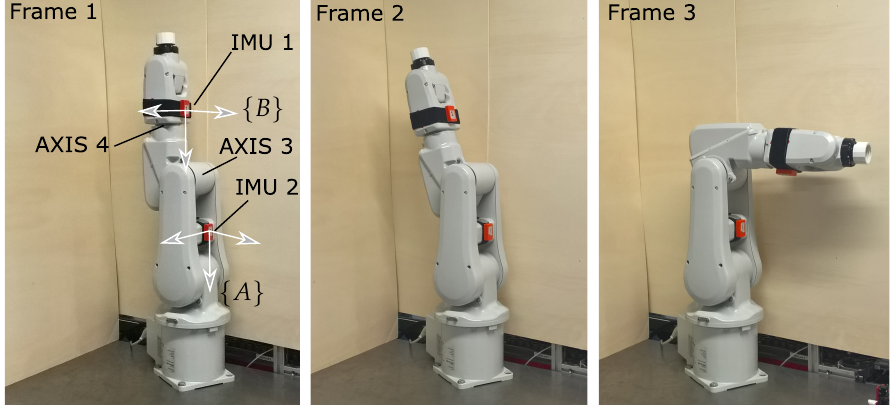
Figure 3. Illustration of the used human analogue setup: robotic serial manipulator ABB IRB-120 with inertial measurement units (IMU) sensors and reference frames. The motion sequence is Frame 1 - 2 - 3 - 1.